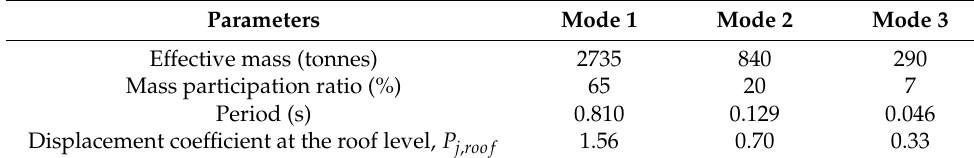
Table A2. Dynamic properties of the case study building obtained from SeismoStruct [41].